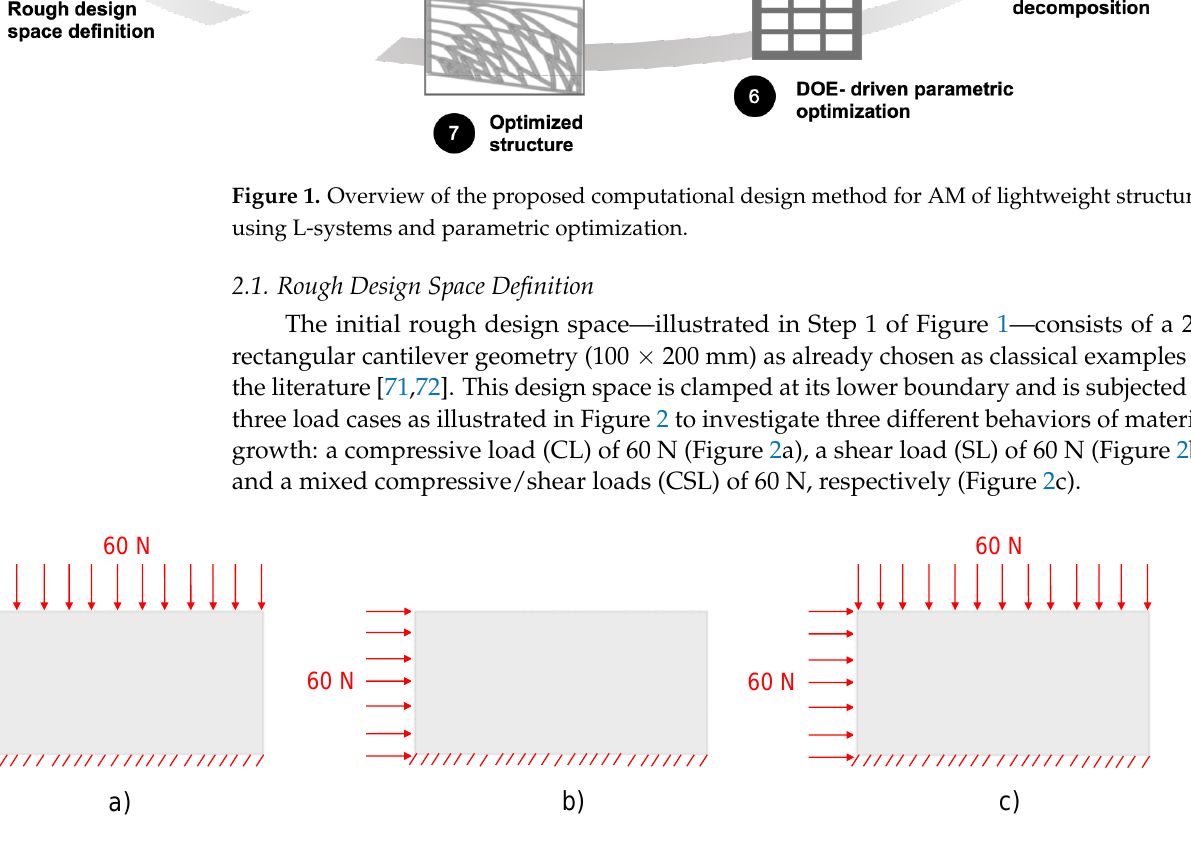
Figure 2. The three studied load cases applied to a 2D design space: ( a ) compression (CL), ( b ) shear (SL), and ( c ) compression-shear (CSL).